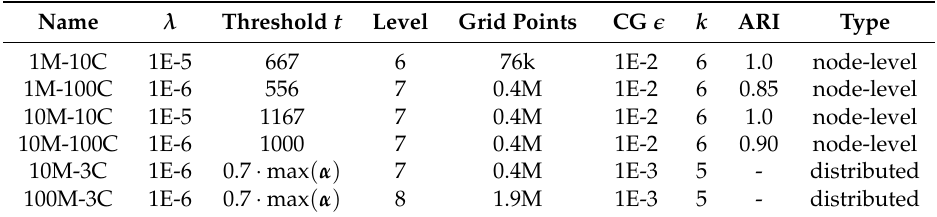
Table 4. The parameters used for configuring the clustering algorithm and the adjusted Rand index (ARI) for the node-level experiments. In the distributed runs, the threshold was specified as a fraction of the maximum surplus of the density function. The node-level runs used an absolute threshold